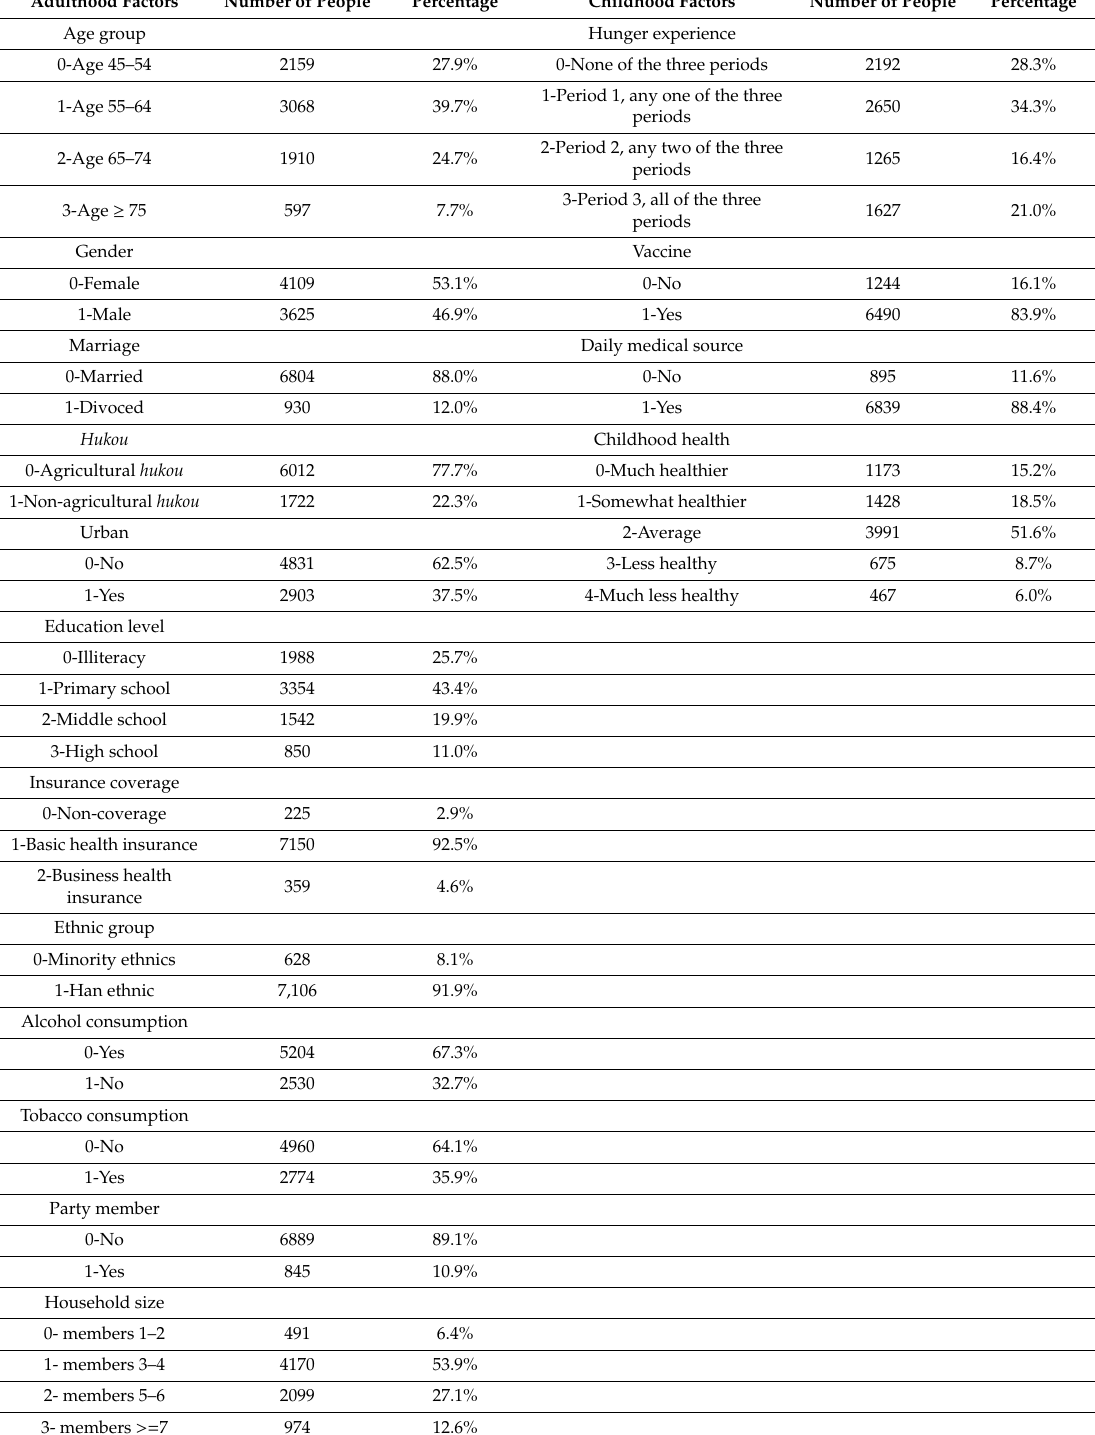
Table 1. Variable definition and summary